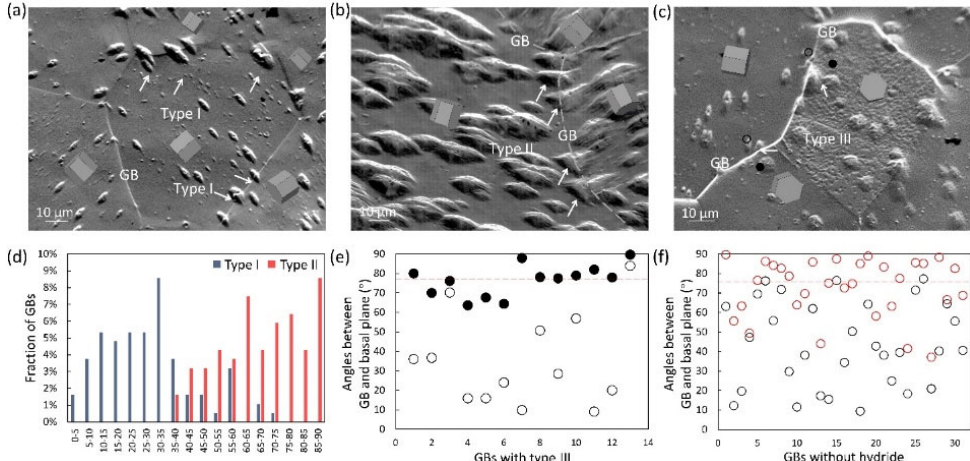
Figure 5. Dependence of intergranular hydride on GB structure [29]. ( a – c ) SEM images showing three types of intergranular hydride bump; ( d ) distribution of type I and type II hydride bumps vs. c-axis misorientation; ( e ) distribution of type III hydride bumps vs. GB-plane–basal-plane angle; ( f ) characteristics of GBs without hydride. Reprinted with permission from [29]; Copyright 2021 Else- vier.